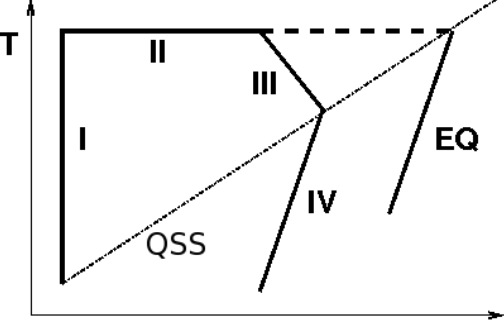
Figure 16: Scheme of the evolution of pulse-heated loop plasma of Figure 15 in a density-temperature diagram ( solid line ). The four phases are labeled. The locus of the equilibrium loops is shown ( dashed- dotted line , marked with QSS), as well as the evolution path with an extremely long heat pulse ( dashed line ) and the corresponding decay path (marked with EQ). Image adapted from Reale (2007), copyright by